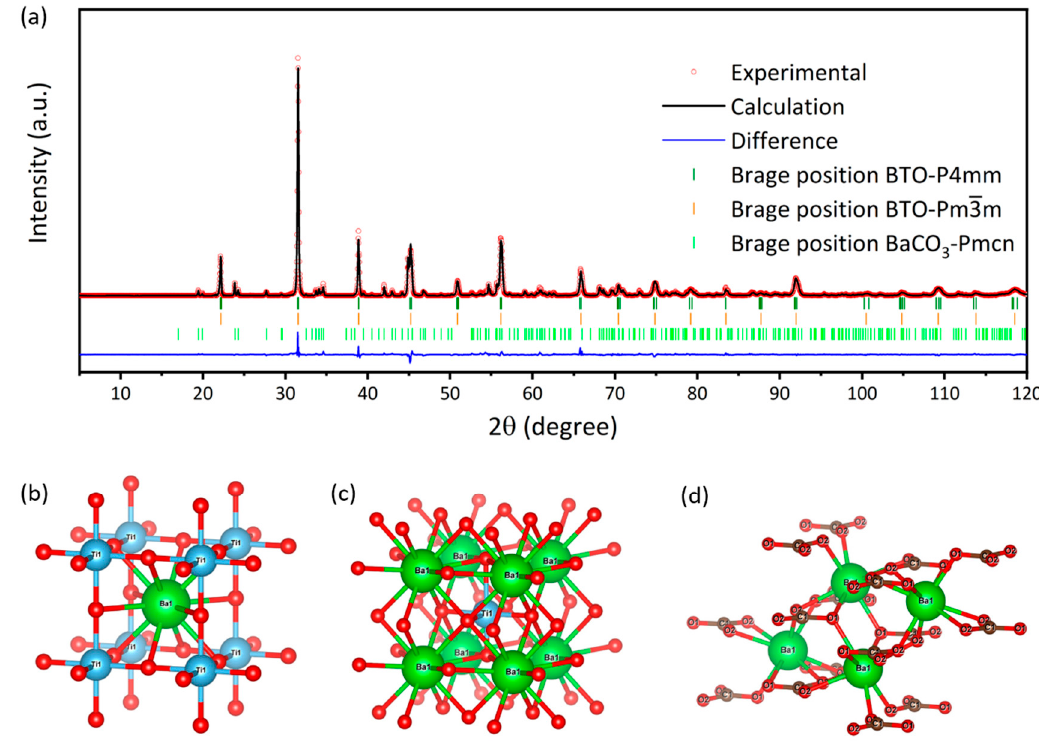
Figure 3. ( a ) Rietveld refined XRD pattern of the BTO nanofibers. ( b – d ) The refined crystal lattice structures of ( b ) BaTiO 3 -Pm-3m, ( c ) BaTiO 3 -P4mm, and ( d ) BaCO 3 -Pmcn.